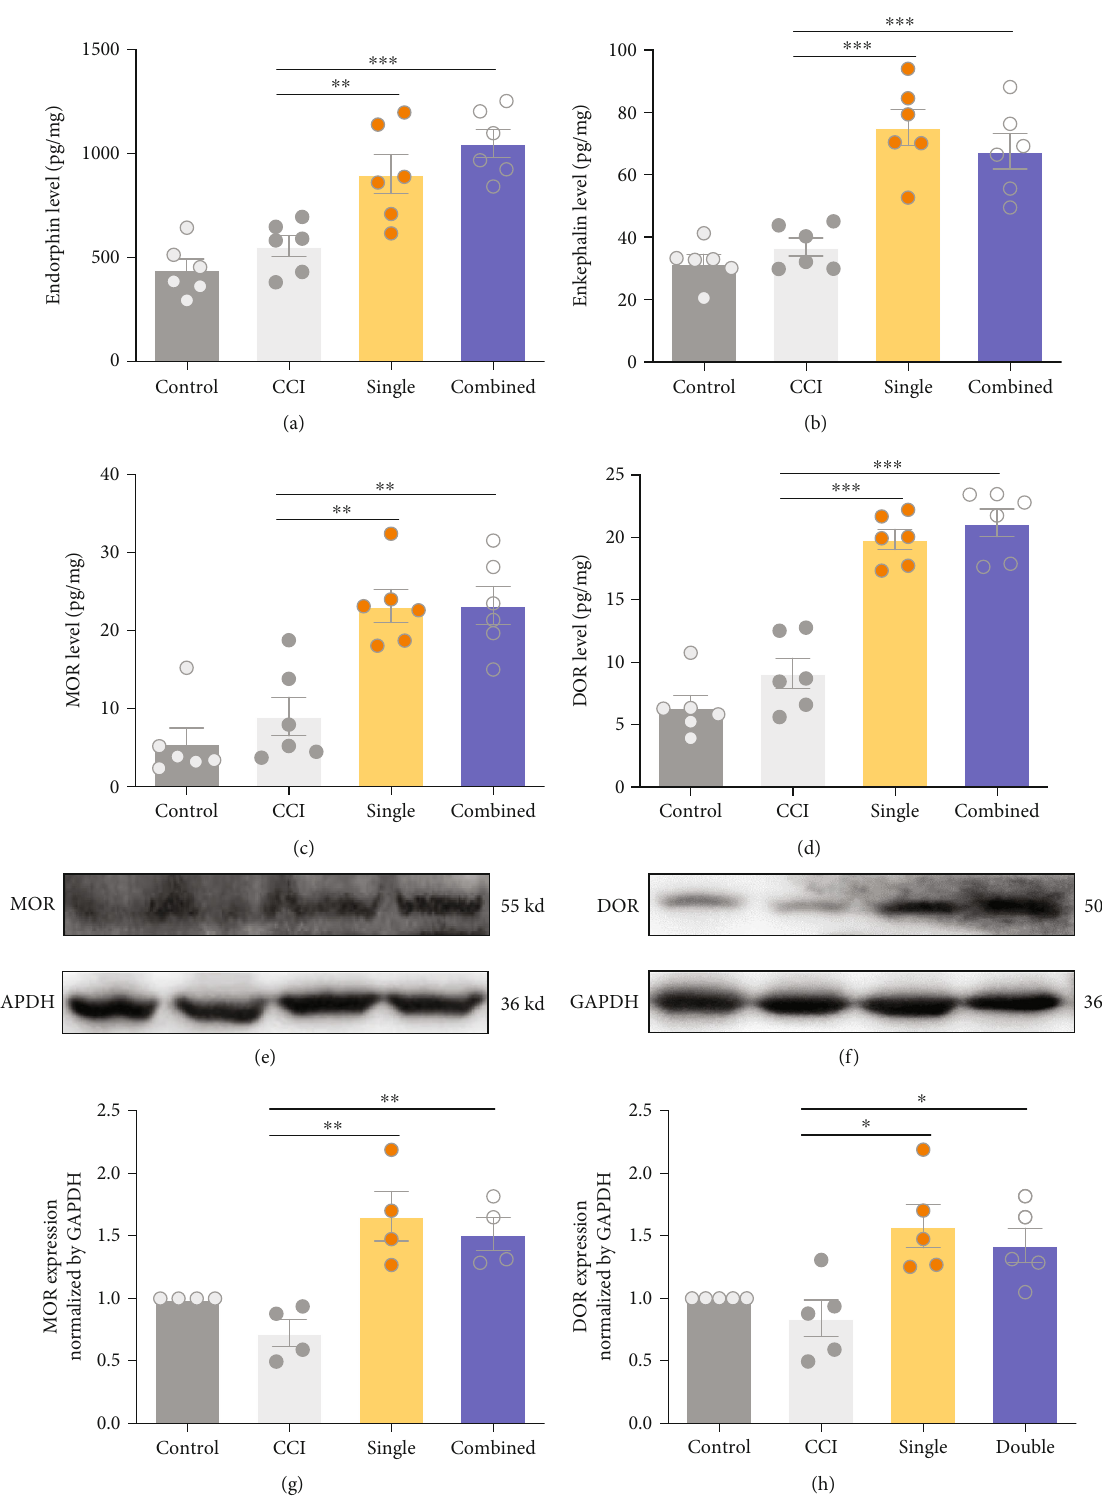
Figure 4: Both single and combined-acupoint EA activated endogenous opioid system. ELISA assay indicated the release of endorphin (a) and enkephalin (b) in both single and combined-acupoint EA groups increased at day 6 after EA treatment. ELISA assay showed that the expression of MOR (c) and DOR (d) was upregulated signi fi cantly in the single and combined groups. (e) – (h) The western blot analysis also con fi rmed the increased expression of MOR and DOR in both single-acupoint and combined-acupoint EA-treated rats. Student ’ s unpaired t -test. All data are mean ± SEM , ∗ P < 0 : 05 , ∗∗ P < 0 : 01 , ∗∗ P < 0 : 01 vs. CCI; N = 6 in each group. CCI: chronic constriction injury; EA: electroacupuncture; MOR: μ -opioid receptor; DOR: δ -opioid